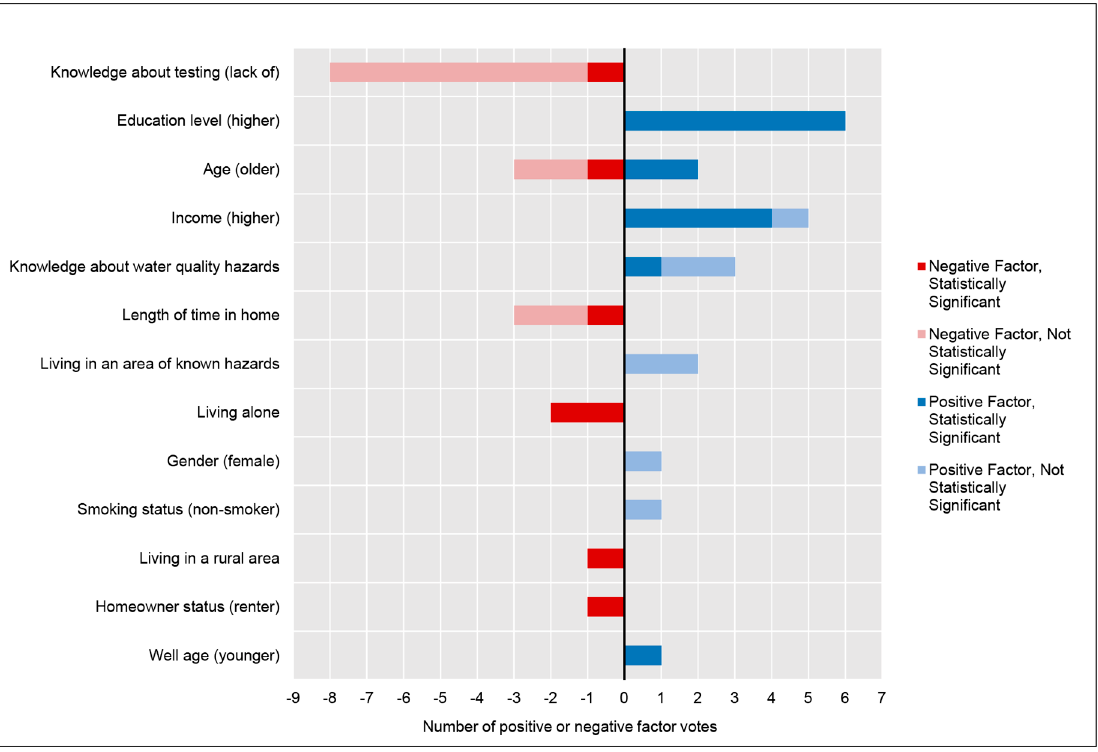
Figure 3. Counts and associations of modifying factors identified in the literature. Modifying factors are primarily demographic, structural, or socio-psychological variables that can influence behavior. Factors are presented in order from the most prevalent to least prevalent in the literature.